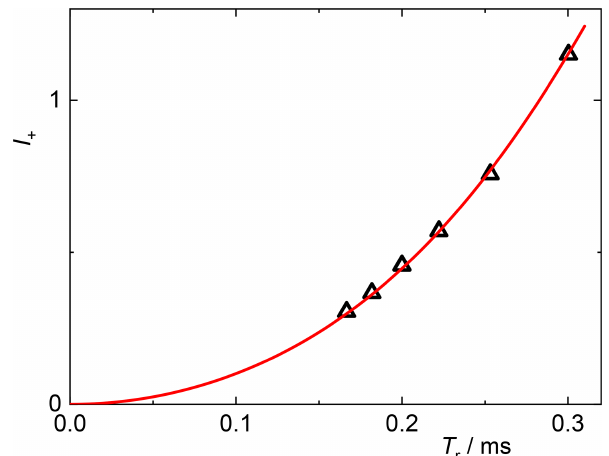
Figure 4. I + vs. rotation period T r for the COO resonance of glycine; triangles: data from experiments with different spinning speeds; red curve: best fit of the I + polynomial to the experimental data. Table 1. CS tensor parameters of glycine obtained by the polyno- mial procedure and comparison with literature values (Griffin et al., 1975; Haberkorn et al., 1981). Group δ /ppm η COO-measured − 74 . 1 ± 0 . 8 0 . 98 ± 0 . 02 literature value − 70 . 65 ± 1 0.97 CH 2 -measured 23 . 46 ± 0 . 25 0 . 60 ± 0 . 03 literature value 20 ± 1